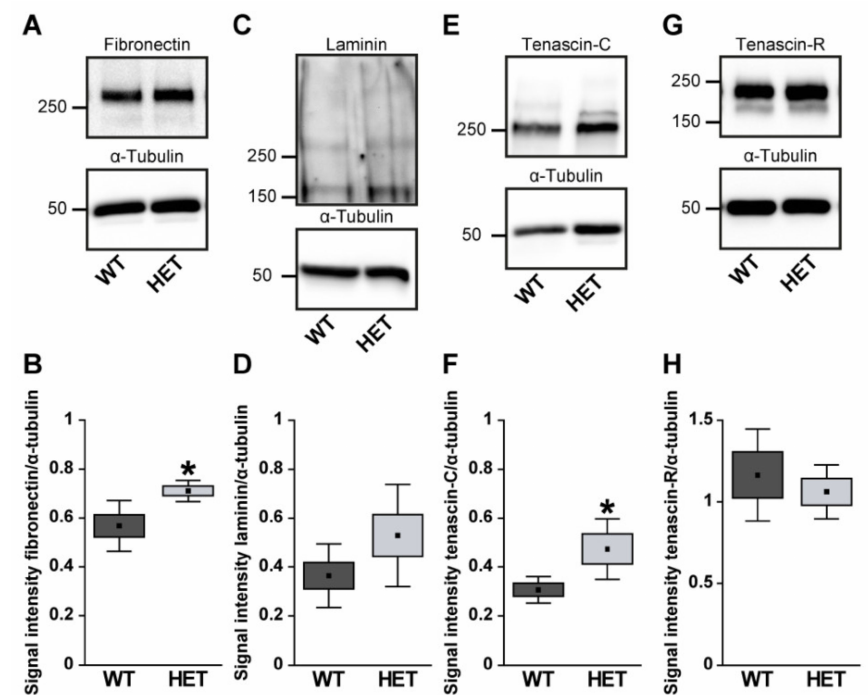
Figure 3. Western blot analyses of glycoproteins of WT and HET retinal tissue. A significantly increased protein band intensity was observed for fibronectin ( A , B ) and tenascin-C ( E , F ) in glau- comatous HET mice. Relative protein quantification revealed a slightly enhanced band intensity of laminin ( C , D ) in the HET group. Comparable protein levels of tenascin-R were found in both genotypes ( G , H ). Groups were analyzed by Student‘s t -test. Data are shown as mean ± SEM ± SD. * p < 0.05. n =